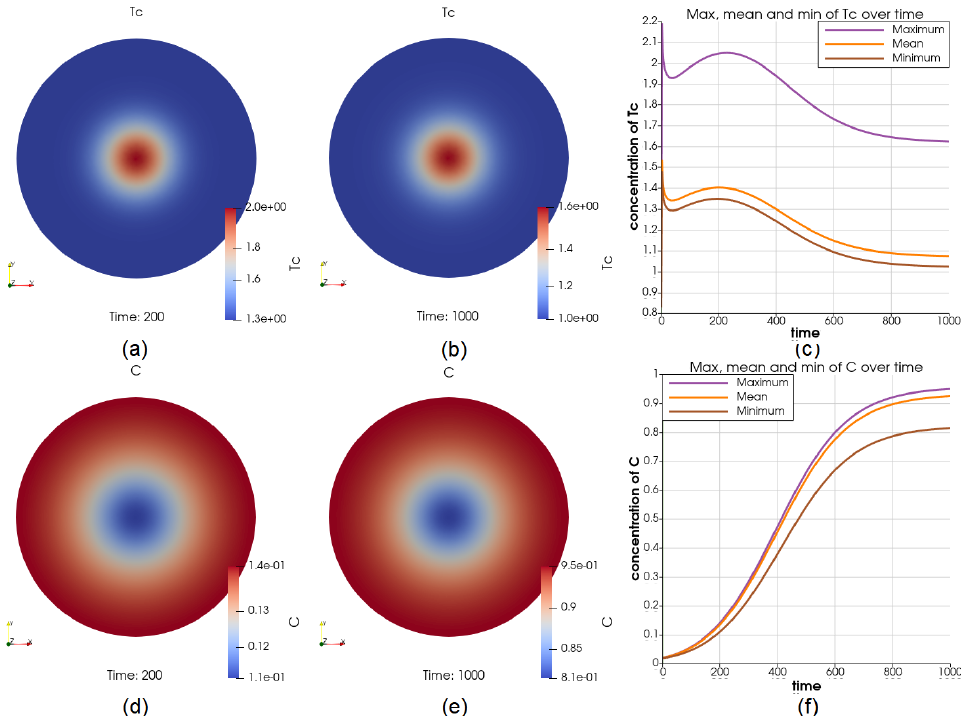
Figure 8. Illustrations for the case of a source of T c in the middle. Part ( a , b ) show the value of T c at t = 200 and t = 1000, respectively; ( c ) shows the dynamics of the maximum and minimum of T c , depicting that the value of T c in the middle is constantly higher than it on the boundary by a considerable amount; the cancer cell concentration at t = 200 and t = 1000 are shown in ( d , e ); the value of the maximum and minimum of C over the whole time interval is shown in ( f ), where the growth of cancer cells in the middle are inhibited strongly by the higher concentration of T c